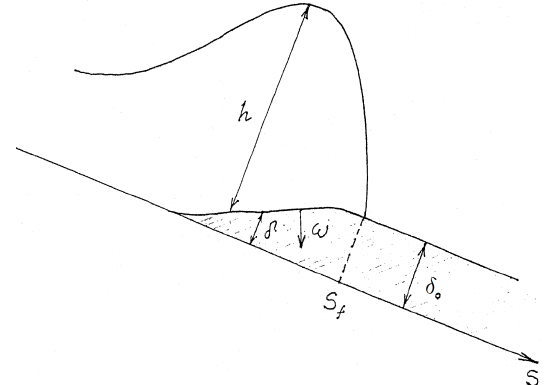
Figure 2. Entrainment near the front of the avalanche. The interface between the snow cover (with original depth δ 0 ( S ) and instantaneous depth δ ( S , t ) ) and the flowing avalanche is regarded as a shock front that propagates into the snow cover with normal velocity ω